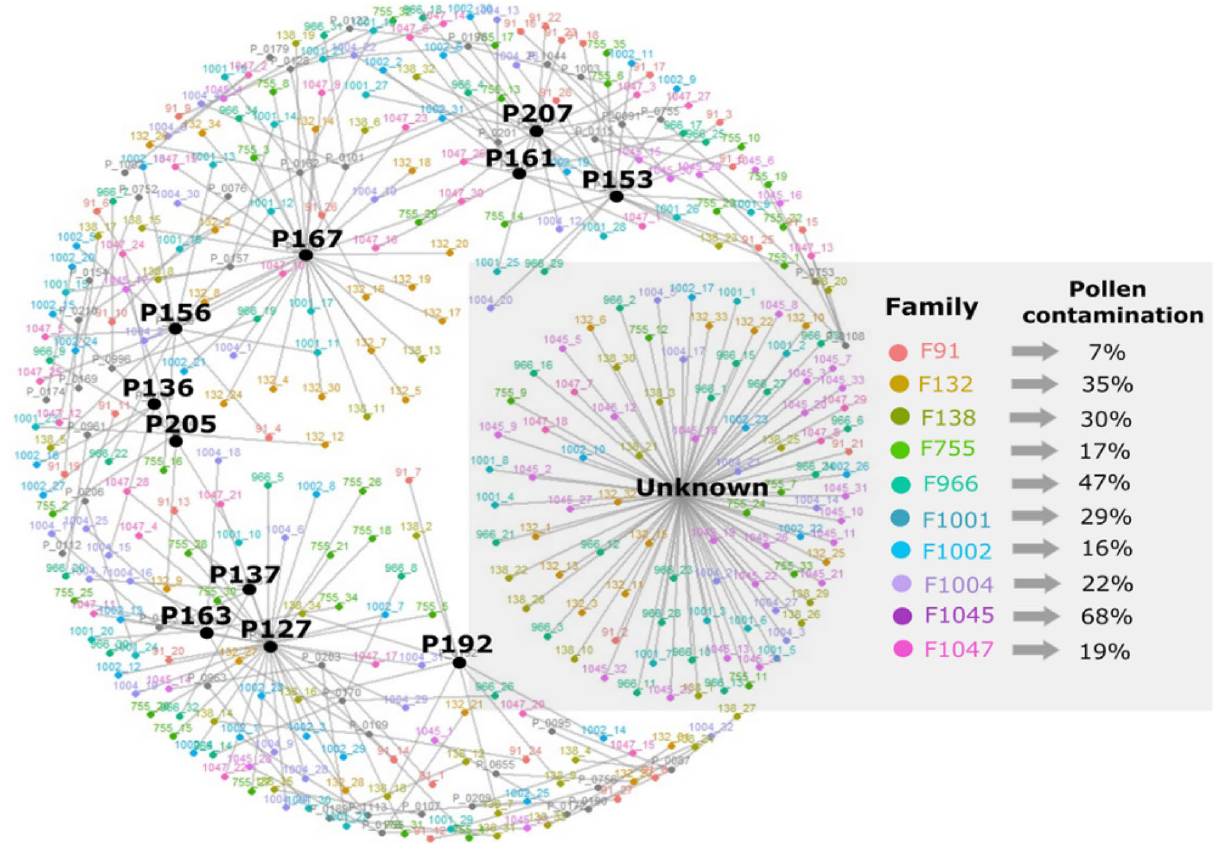
Figure 5. Network diagram representing the pedigree reconstruction of 10 families (328 trees) from a 15-year- old progeny trial (two sites) associated with the Region G1 white spruce program. Using 2000 SNPs, paternal (P, large black dots) assignment was achieved using CERVUS and COLONY software with the 10 known mothers (small coloured dots). For each of the 10 families (F), the per cent (%) pollen contamination from all unknown male contributions is highlighted in the grey